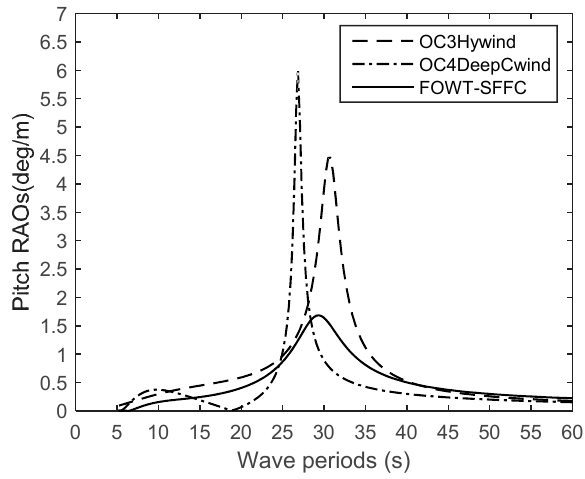
Figure 6. Pitch response amplitude operators (RAOs) of three concepts of offshore wind turbines.